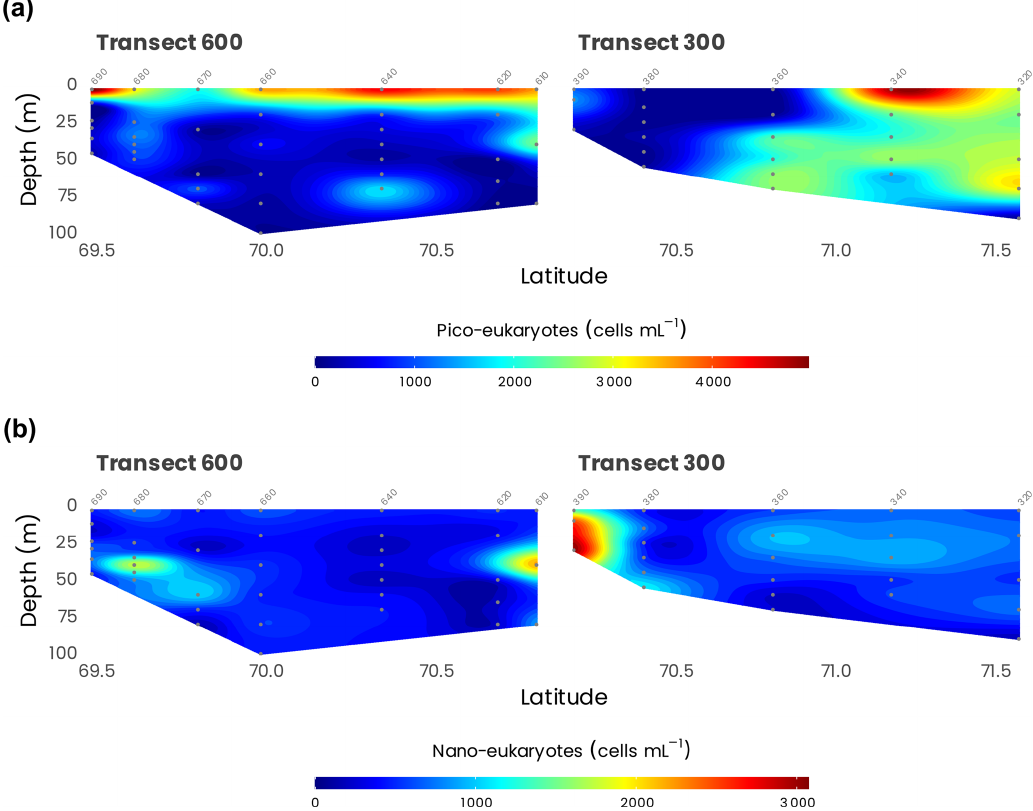
Figure 11. Concentrations of photosynthetic (a) pico- and (b) nano-eukaryotes measured by flow cytometry during the MALINA cruise on transects 600 and